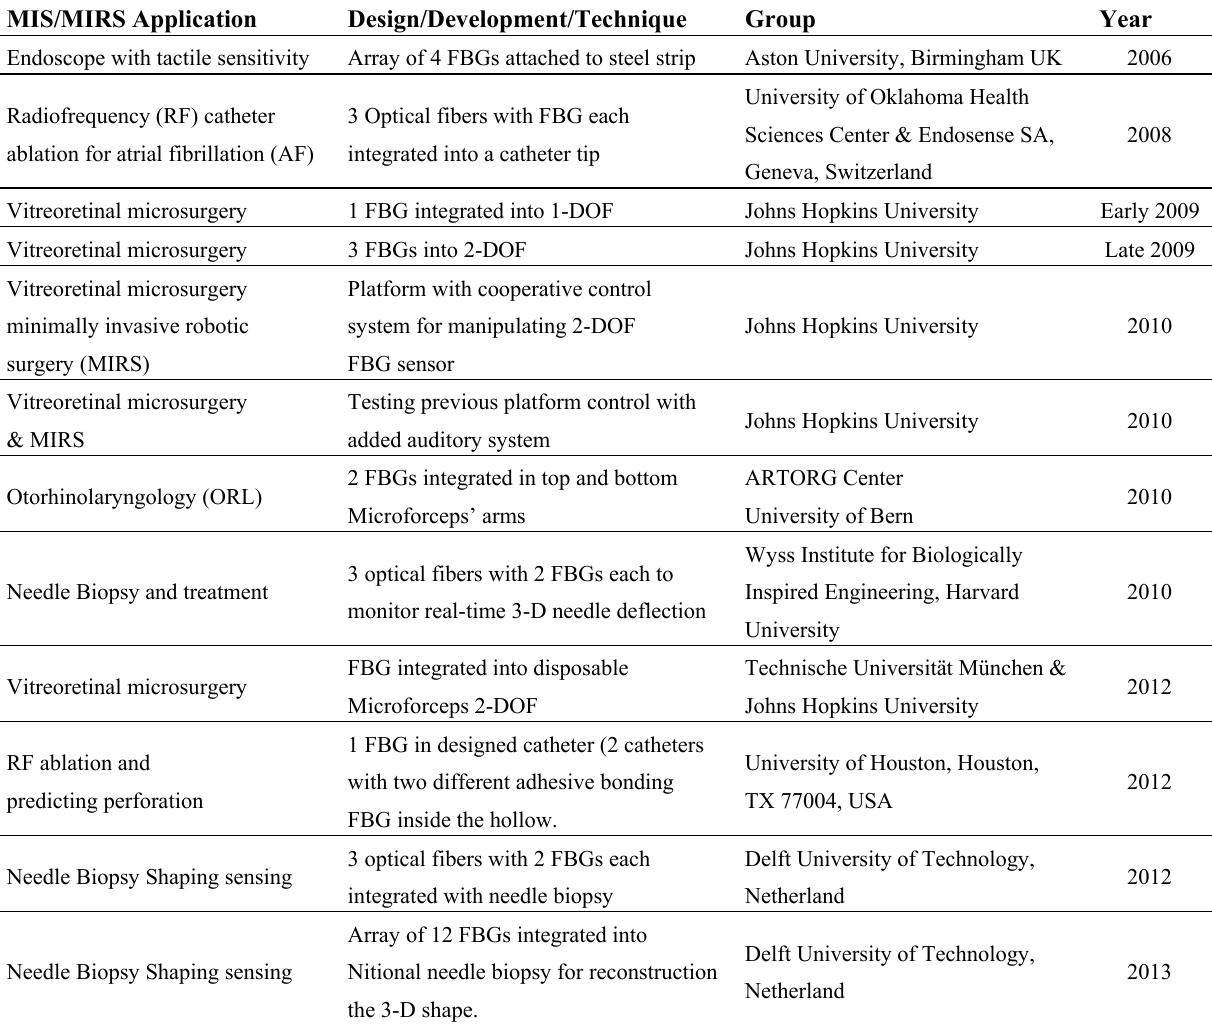
Table 1. Various FBG tactile sensors developed in MIS